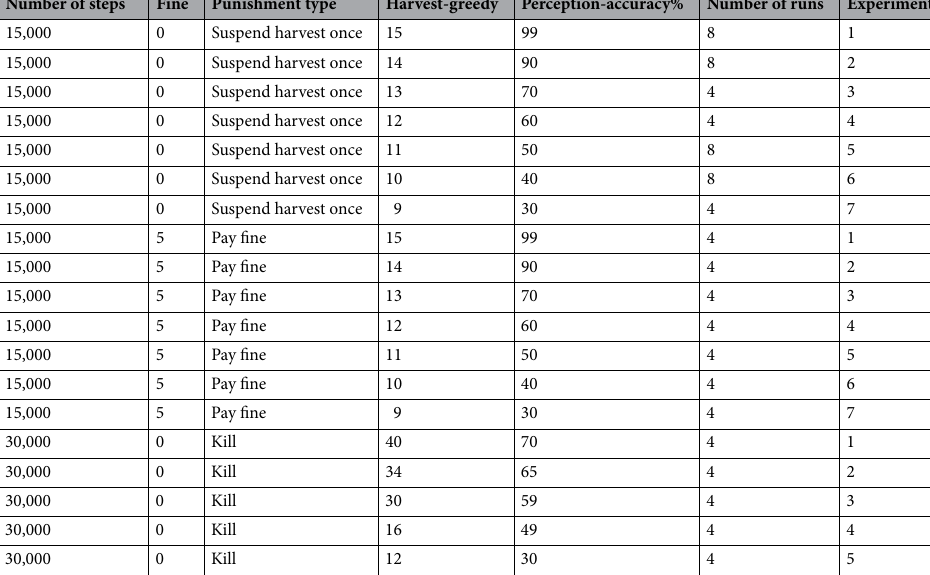
Table 1. Experimental details of the second model. The correlation coefficient (r) = 0.99 (rounded to 2 decimal places) for the first and second punishment types (suspend harvest once/pay fine). In addition, (r) = 0.95 (rounded to 2 decimal places) for third punishment type